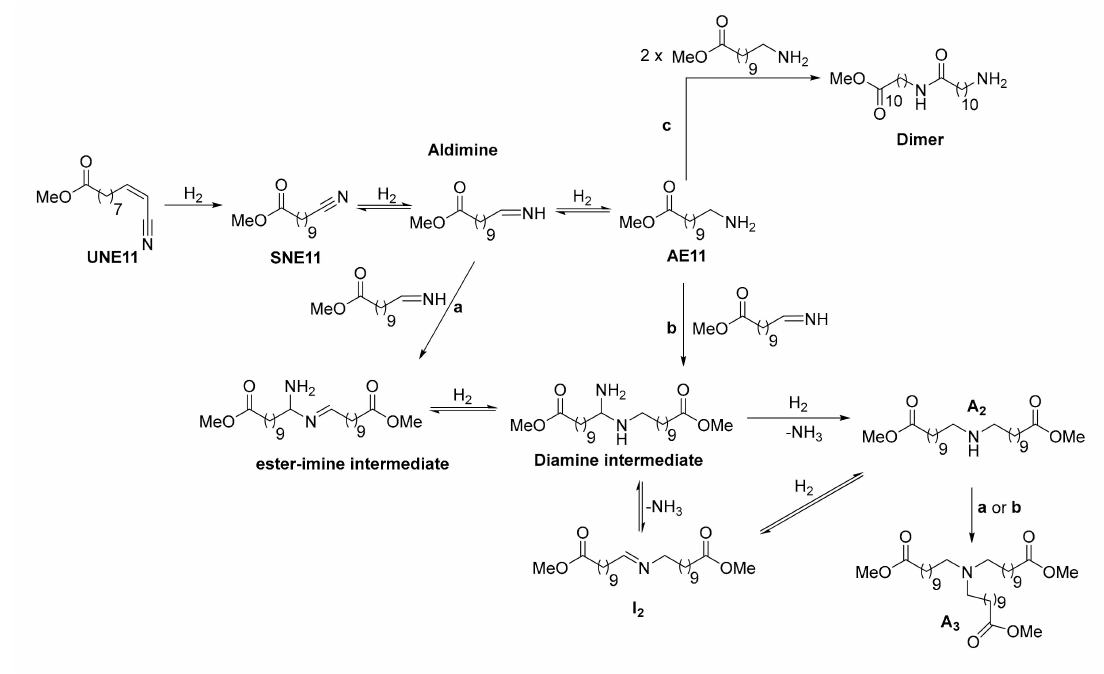
Scheme 2. Hydrogenation of UNE11 to AE11 and corresponding side-reactions. Formation of a secondary amine and tertiary amine: ( a ) via condensation between two primary imines; ( b ) via condensation amine-imine. Dimer formation ( c ) via condensation of two AE11 molecules. UNE11